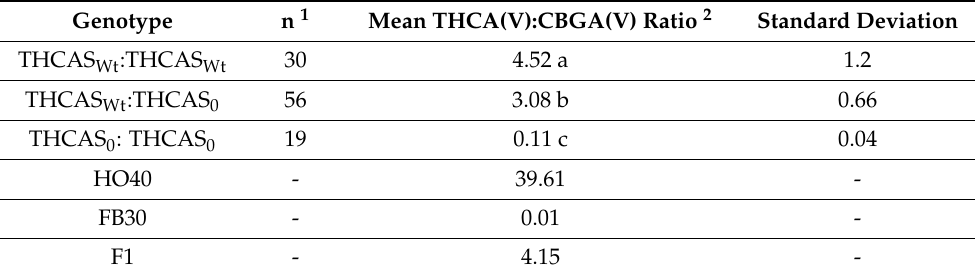
Table 4. Mean THCA(V):CBGA(V) ratios among three genotypes tested in Cross